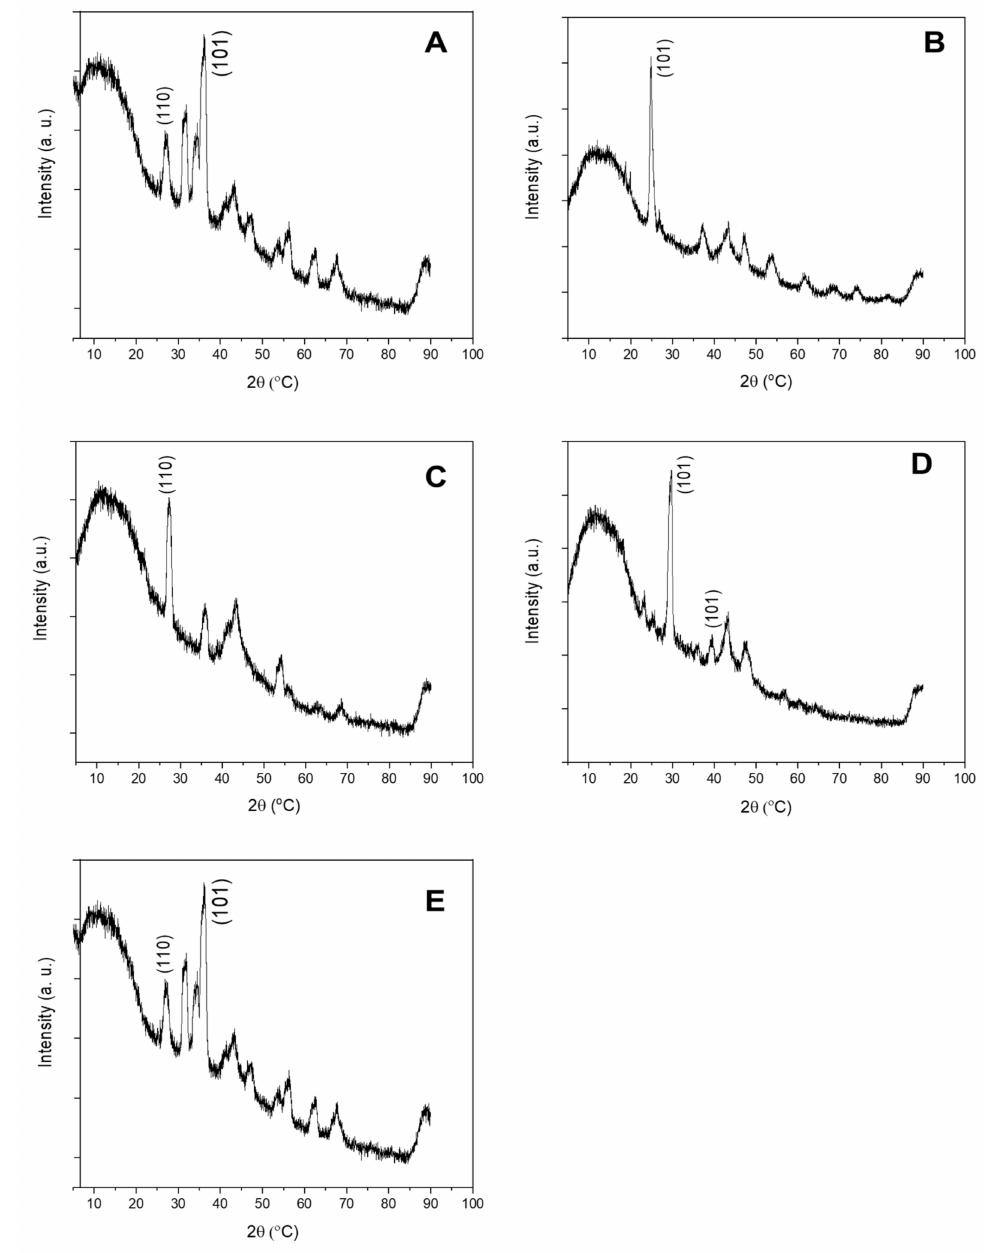
Figure 3. The XRD patterns of SUN1 ( A ), SUN2 ( B ), SUN3 ( C ), SUN4 ( D ), and SUN5 ( E